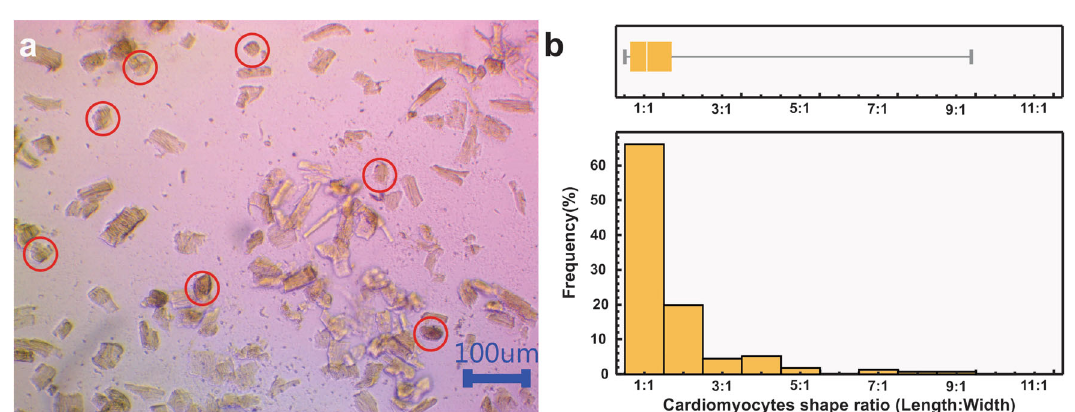
Fig. 3 a ARVC at 7th day of culture. b ARVC shape ratio ( R L:W ) histogram and